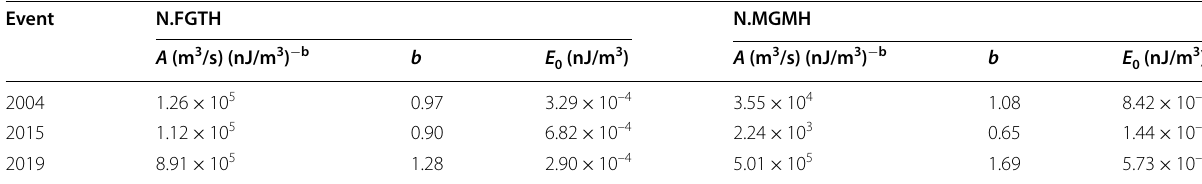
E 0 values are calculated from the average seismic noise level obtained two days prior to the flood for each event